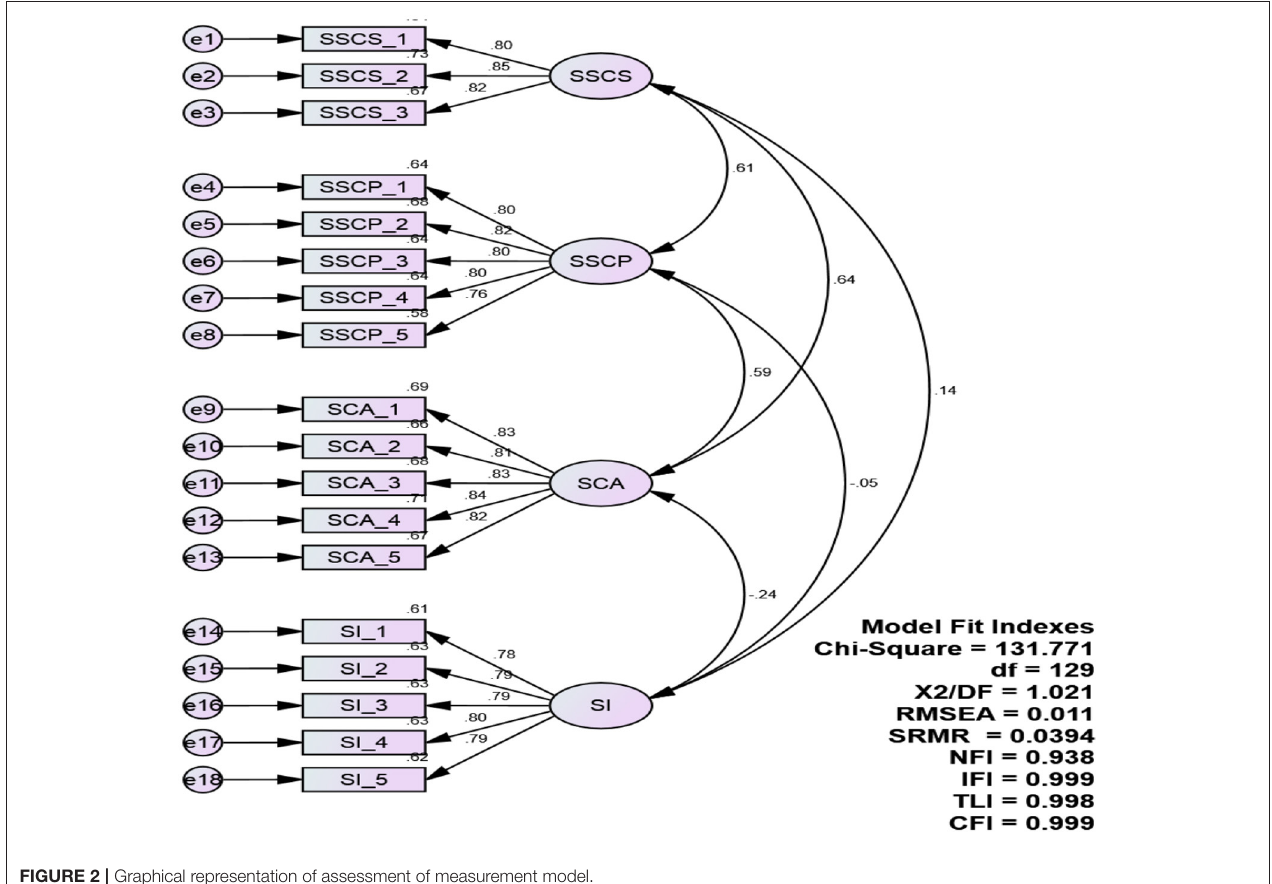
FIGURE 2 | Graphical representation of assessment of measurement model. TABLE 3 | Discriminant validity analysis (Fornel Larcker and HTMT). Constructs